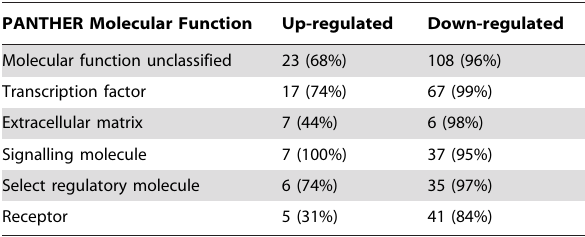
Table 8. Number of genes in over-represented PANTHER categories with binding sites for one or more of the homeobox transcription